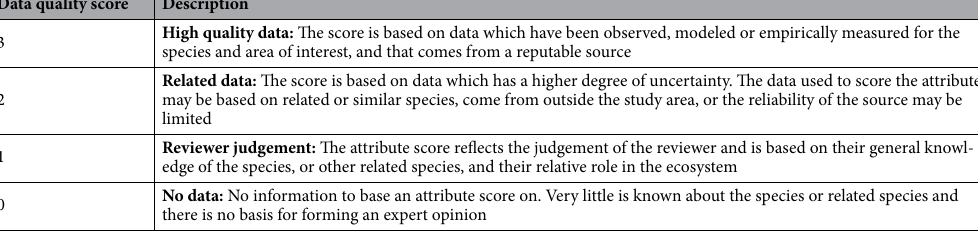
Table 3. Data quality scores for the vulnerability assessment of key fishery resources to climate change in the Northern Humboldt Current System (adapted from a previous study 49